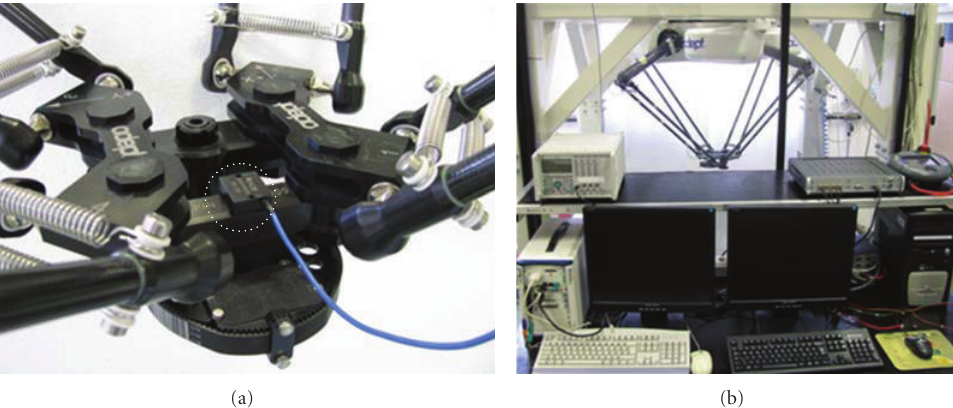
Figure 13: (a) The MEMS accelerometer (in the dotted circle) fixed on the moving platform. (b) The experimental setup.